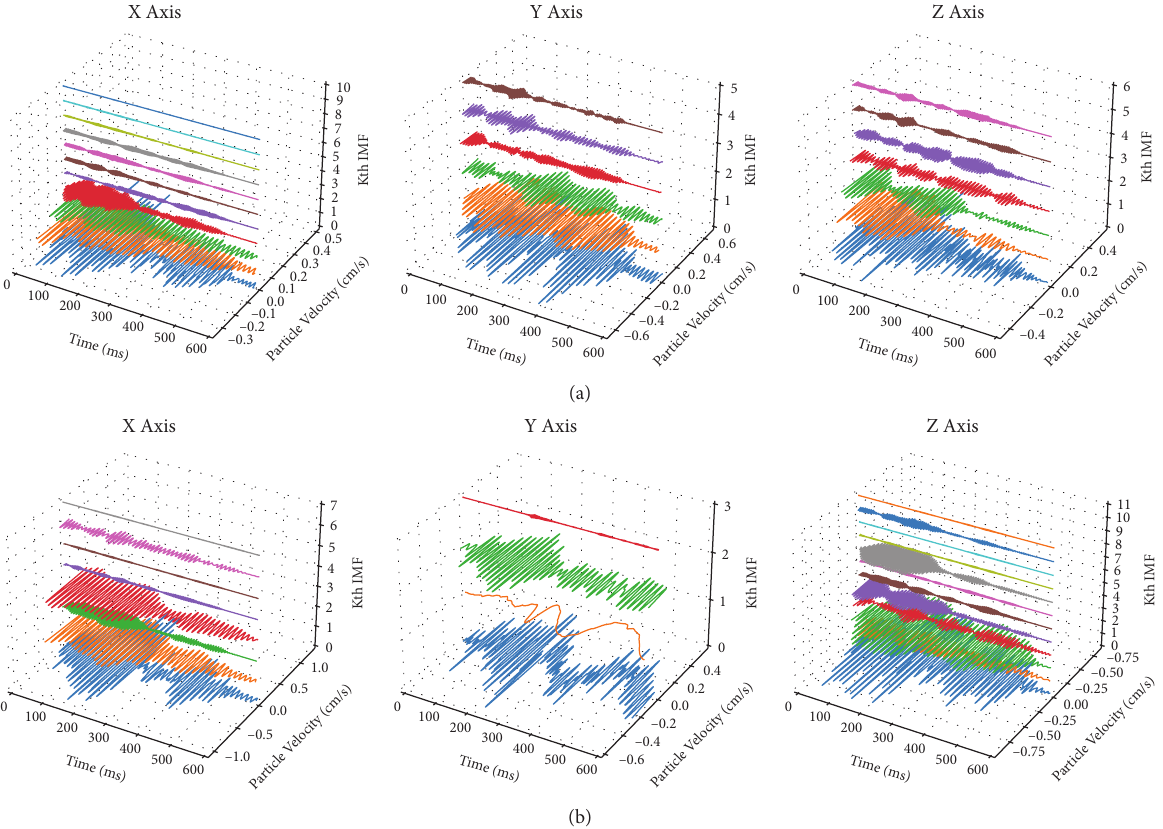
Figure 9: Typical time history curves of vibration velocity with (k) IMFs. Each line represents an IMF. k � 0 is the original signal. (a) Monitoring point 2 at +10m; (b) monitoring point 5 at −